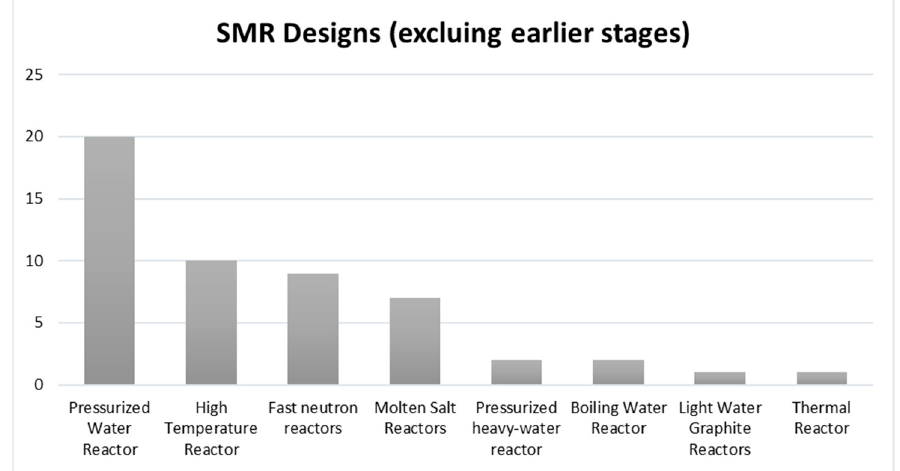
Figure 1. SMRs under development.